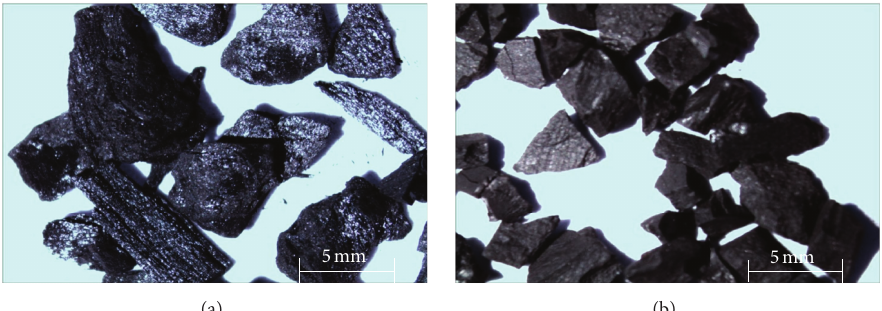
Figure 1: (a) Fusinitic coal (scale = 5mm) and (b) xyloid coal (scale = 5mm).